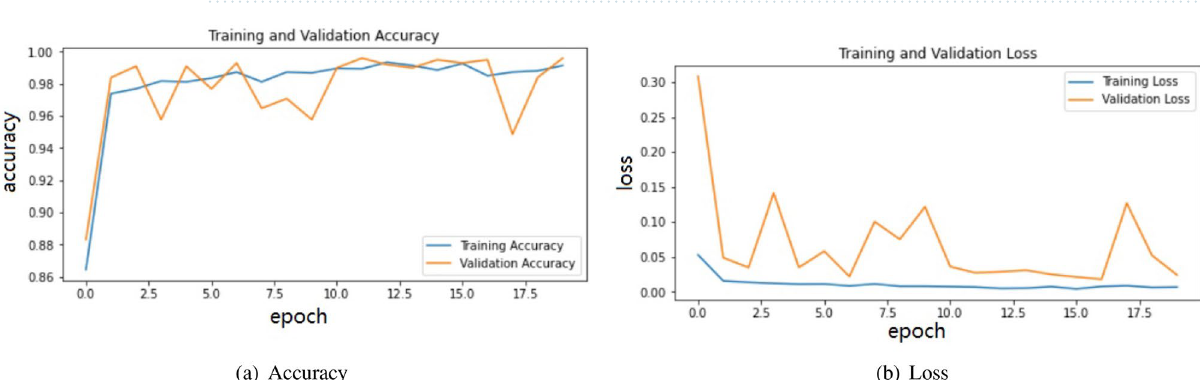
Figure 8. Model VGG16 for COVID-19/pneumonia on X-ray